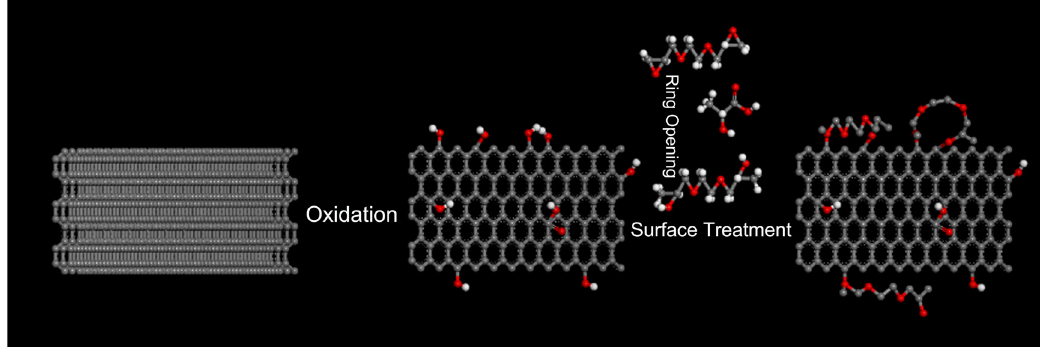
Figure 1: Surface modi fi cation process of GO.